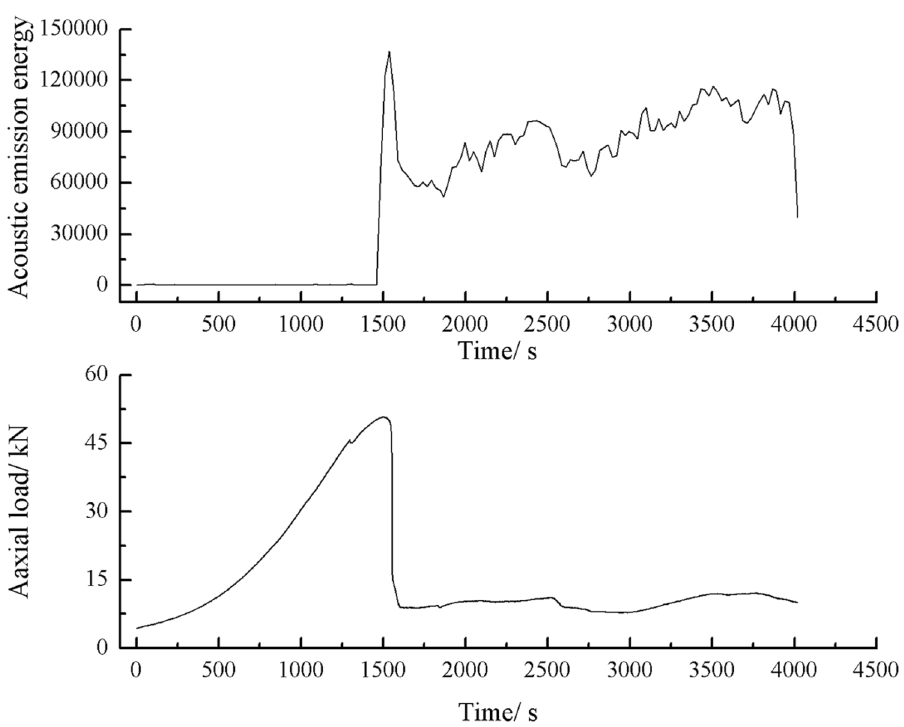
Figure 64. Acoustic emission energy-Axial load curve of the rock mass comprised of two grain size